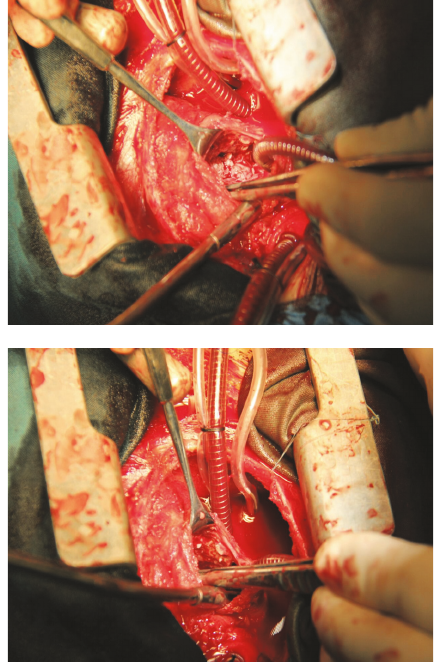
Figure 3: Intracardiac vegetation: one in the tricuspid valve and another in the entrance of SVC to right atrium.